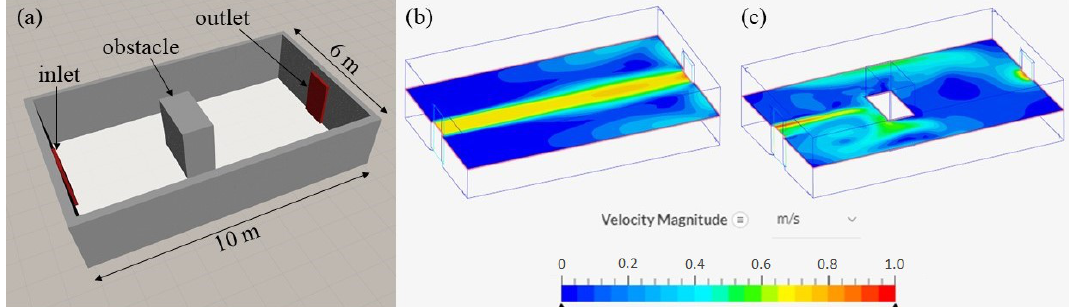
Figure 1. ( a ) Targeted indoor environment with ventilation bounded by walls and ( b ) generated airflow with obstacle-free region and ( c ) generated airflow in obstacle region with a block placed in the middle of the